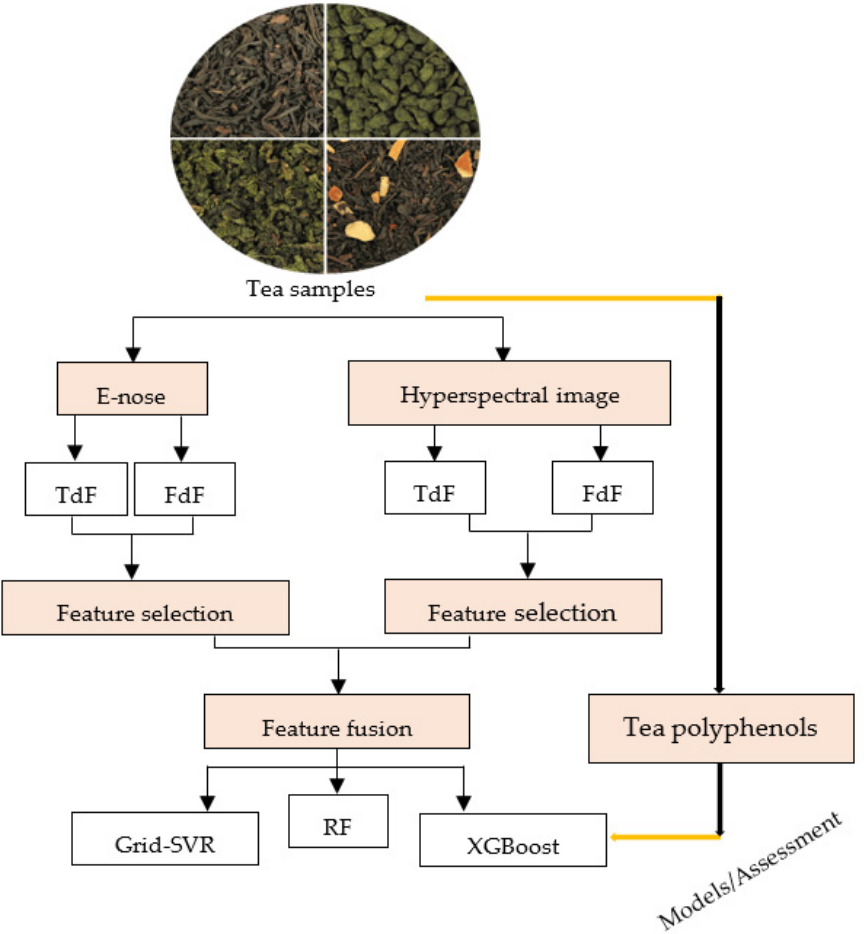
Figure 5. A diagram of a polyphenol evaluation model present in black, green, and yellow teas, based on feature fusion of an e-nose and hyperspectral imagery. FdF: frequency-domain feature, TdF: time-domain feature, Grid-SVR: grid support vector regression, RF: random forest, XGBoost: extreme gradient boosting. Retrieved from Yang et al. [77].